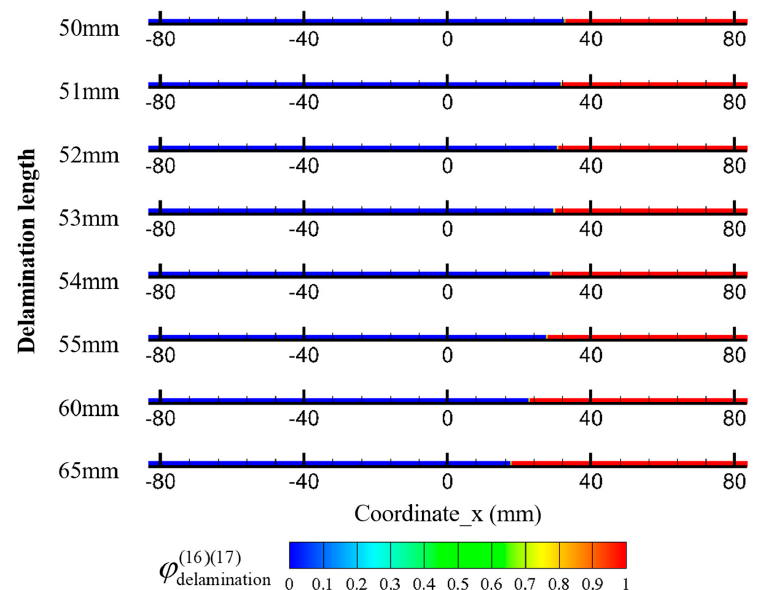
Figure 14. PD modeling delamination growth process damage contours on the mid ‐ plane of DCB specimen, between Layer 16 and 17.